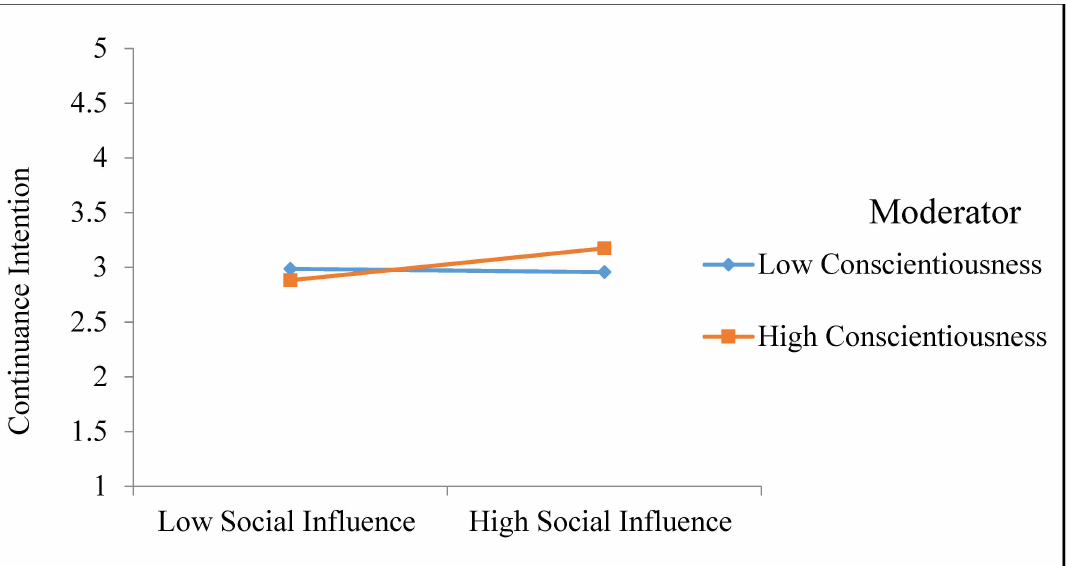
Figure 3. Conscientiousness Strengthens the Positive Relationship between Social Influence and